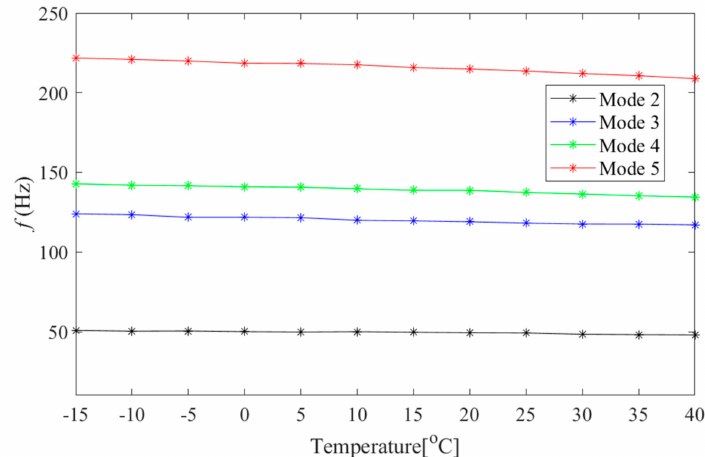
Figure 14. Identified modal frequencies of the wind turbine blade for the test R at different tempera- tures using the SOBI